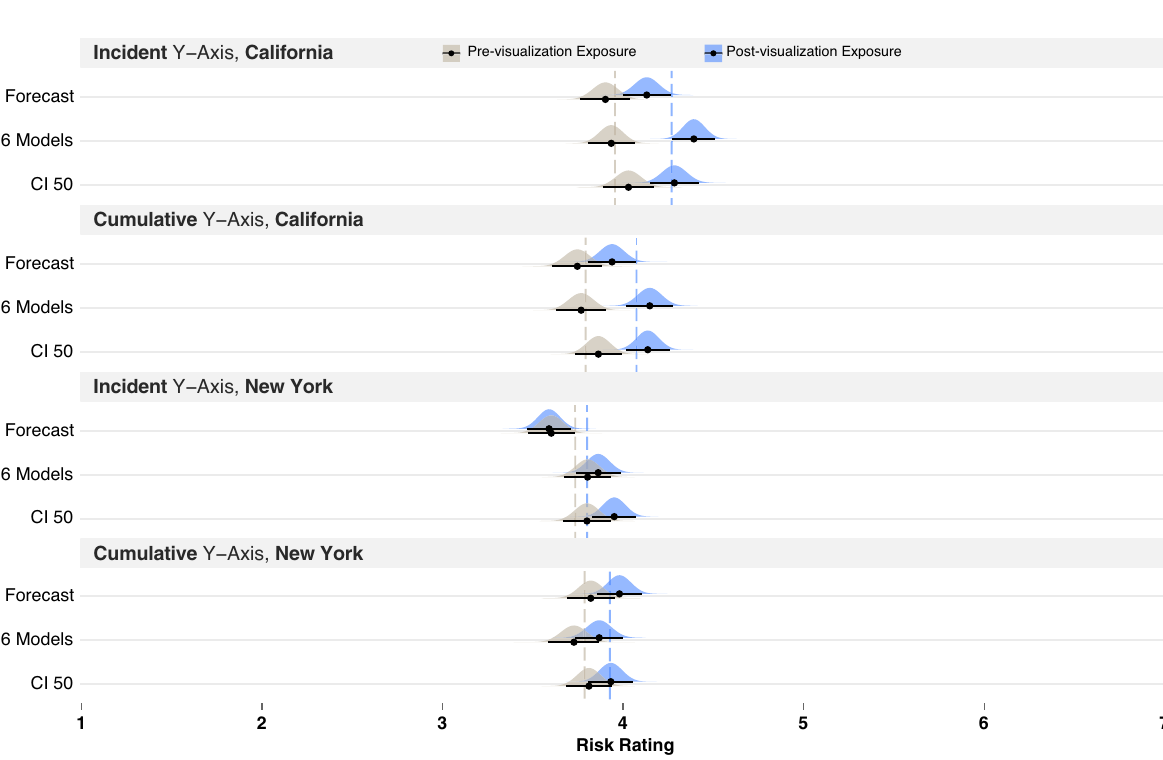
Figure 4. Additional uncertainty visualization techniques tested in Experiment 2 with California data.